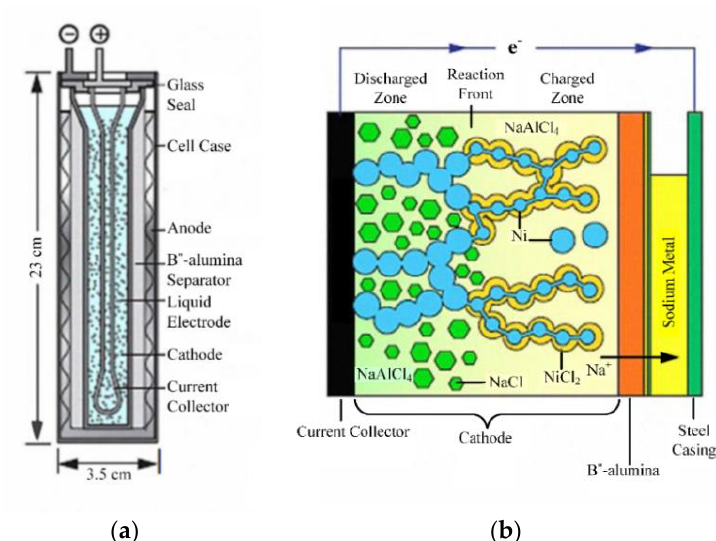
Figure 35. ( a ) Cell schematic highlighting main components of the Sodium metal halide (Na-MX) cell. ( b ) Pictorial representation of the charging reaction, which consumes NaCl to form NiCl 2 from the β”-alumina ceramic separator inward [26].